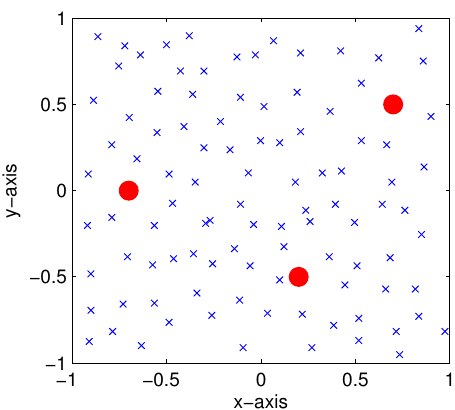
Figure 1. Distribution of anomalies A m (red dots) and random scatterers R s (blue ‘ × ’